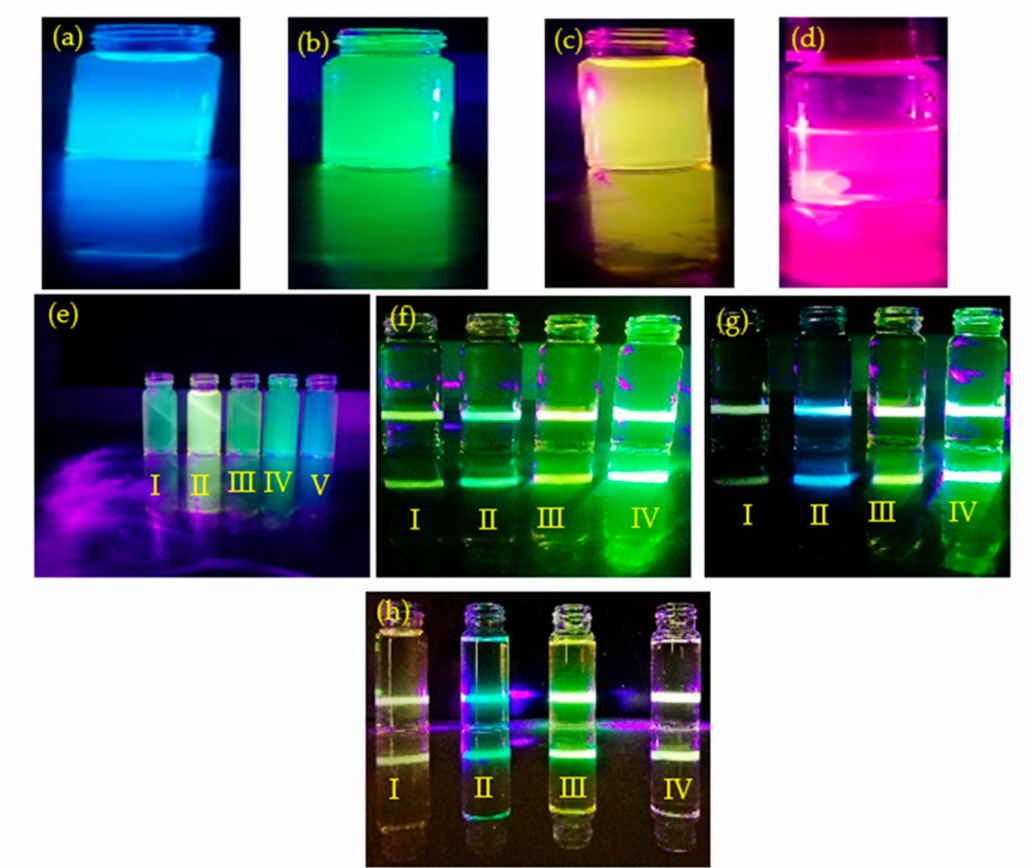
Figure 8. Luminescence from colloidal ZnSiQDs containing various amounts of NH4OH under different excitation ( a–d ) added with 15 µ L, 20 µ L, 25 µ L, and 30 µ L of NH 4 OH excited at 365 nm, respectively; ( e ) bottles I, II, III, IV, and V with 17 µ L, 25 µ L, 19 µ L, 20 µ L, and 15 µ L of NH 4 OH excited at 365 nm added, respectively; ( f ) bottles I, II, III, and IV with 17 µ L, 19 µ L, 22 µ L, and 20 µ L of NH 4 OH excited at 410 nm added, respectively; ( g ) bottles I, II, III, and IV with 17 µ L, 15 µ L, 22 µ L, and 20 µ L of NH 4 OH excited at 410 nm added, respectively; ( h ) bottles I, II, III, and IV with 16 µ L, 15.5 µ L, 21.5 µ L, and 14 µ L of NH 4 OH excited at 410 nm added,